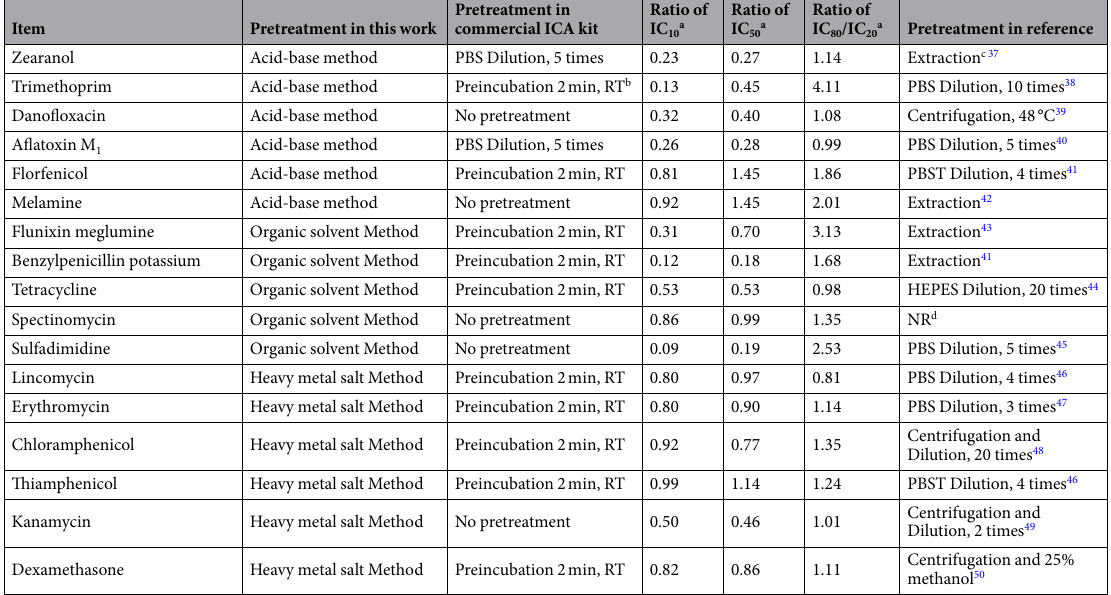
Table 1. Comparison of ICA results with or without proposed pretreatment of 17selected items in milk. a Ratio of IC value of with proposed pretreatment divided by that pretreatment in commercial ICA kit; b Room tempeture; c Method based on non-ICA immunoassay; d Not